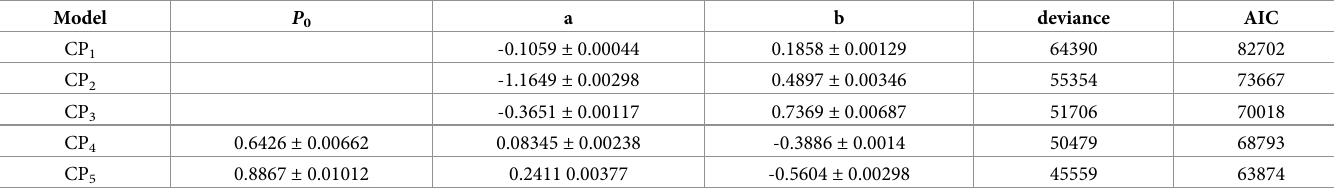
The estimated values of the regression parameters, the deviance, and AIC for each CP model based on the complete data are presented in Table 2. The estimated values of a for CP Table 2. Regression parameters, deviance, and AIC for the complete dataset in each model. Model P